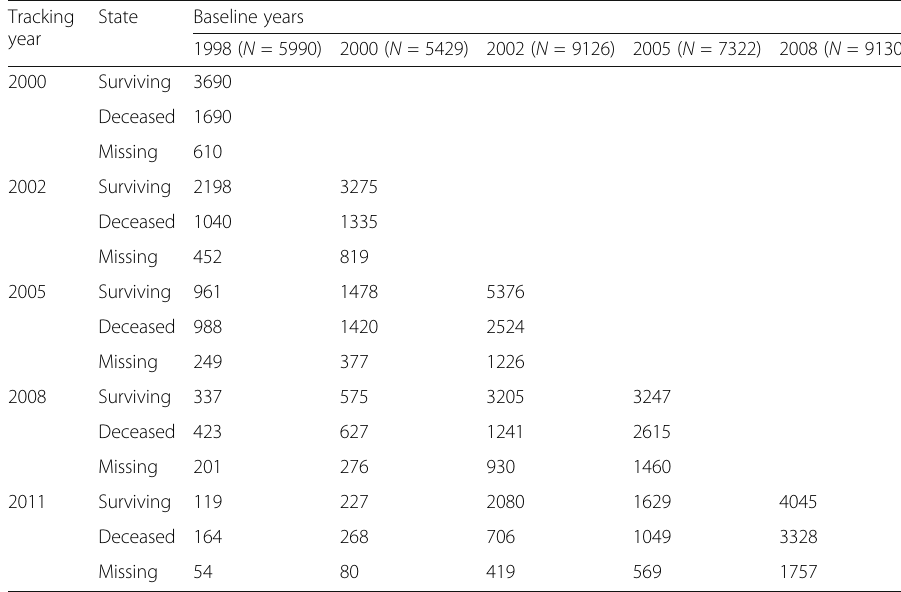
Table 1 Samples of the baseline survey and follow-up information Tracking year